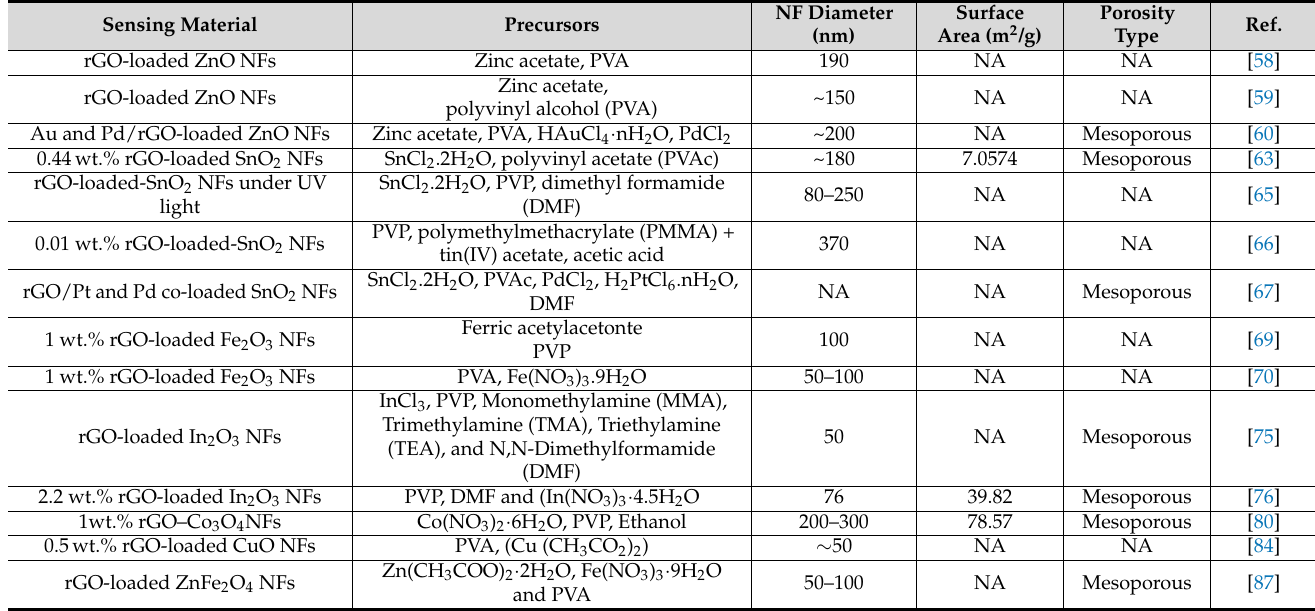
Table 2. Precursors, NF diameter, surface area and porosity nature of rGO-loaded NF gas sensors reported in literature. Sensing Material